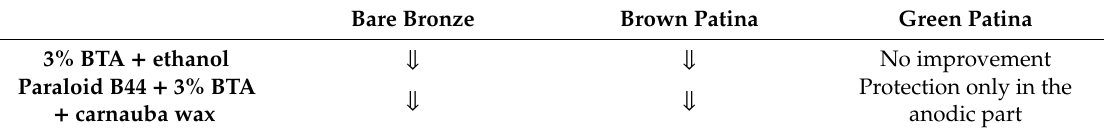
Table 2. Results of potentiodynamic measurements from Kosec et al. [27] when the corrosion current of coated samples was compared with non-coated ones. The arrow ( ⇓ ) indicates the decrease of the corrosion current density and thus the protective properties of the coating.